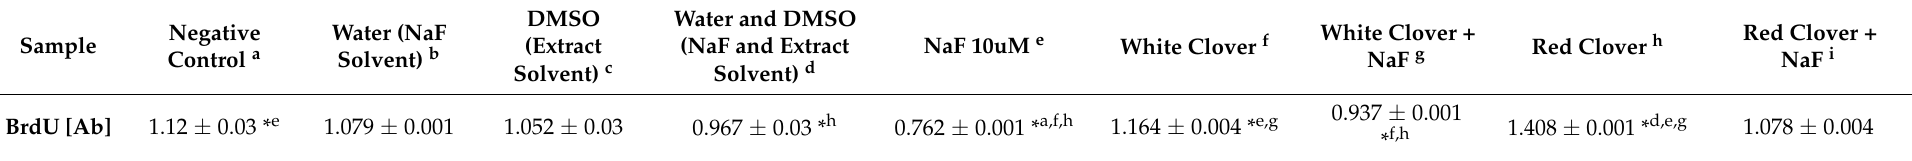
Table 2. Influence of red and white clover flower extract (100 ppm) on proliferation of macrophages incubated with NaF addition. Different letters (a–i) in the columns represent statistically